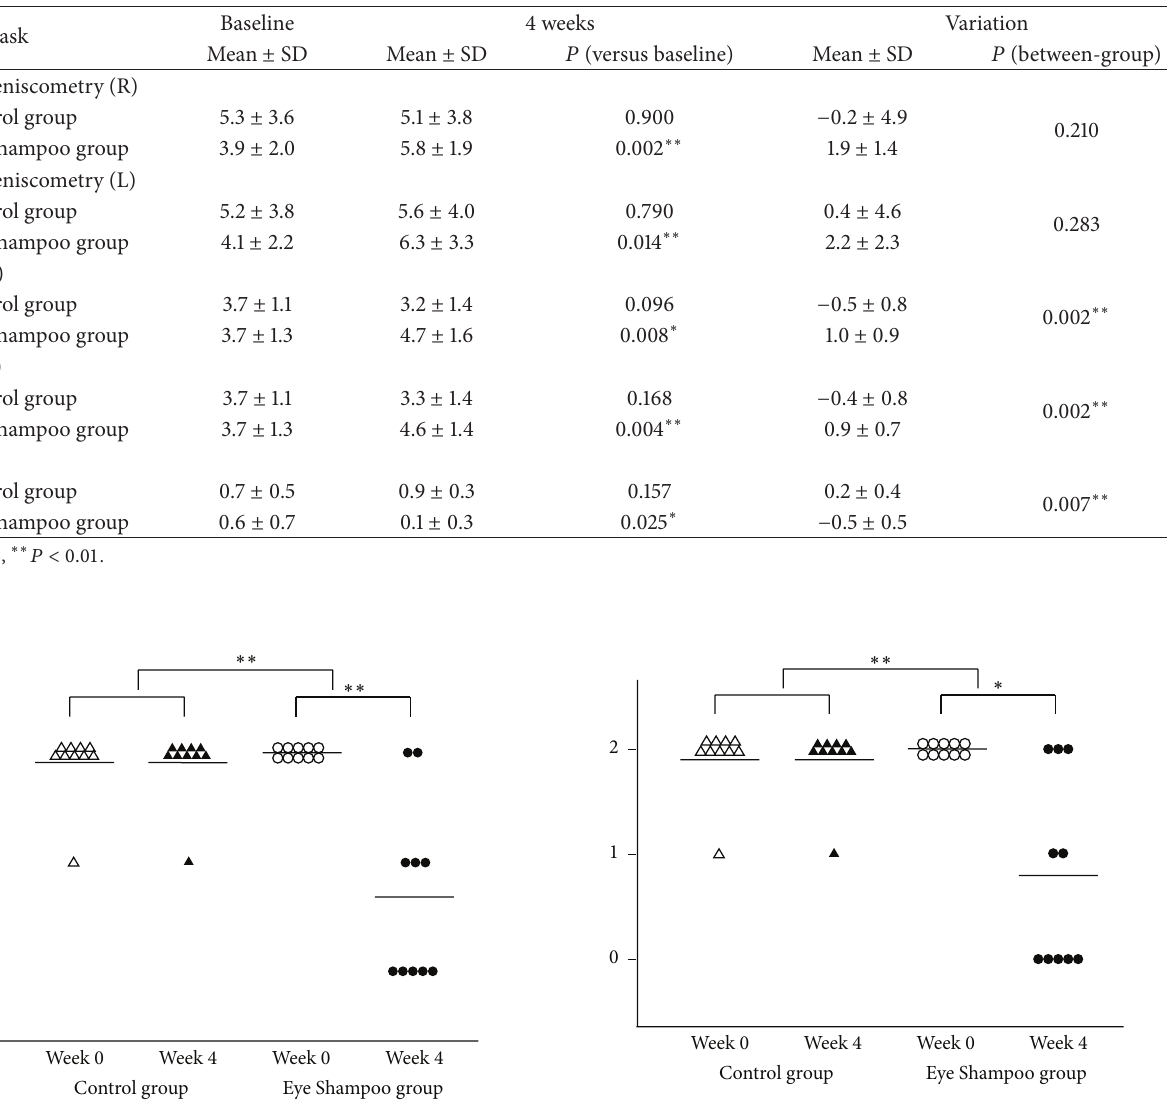
Table 4: Comparison of strip meniscometry, tear film breakup time (BUT), and superficial punctate keratopathy (SPK) between the groups. SD, standard deviation.